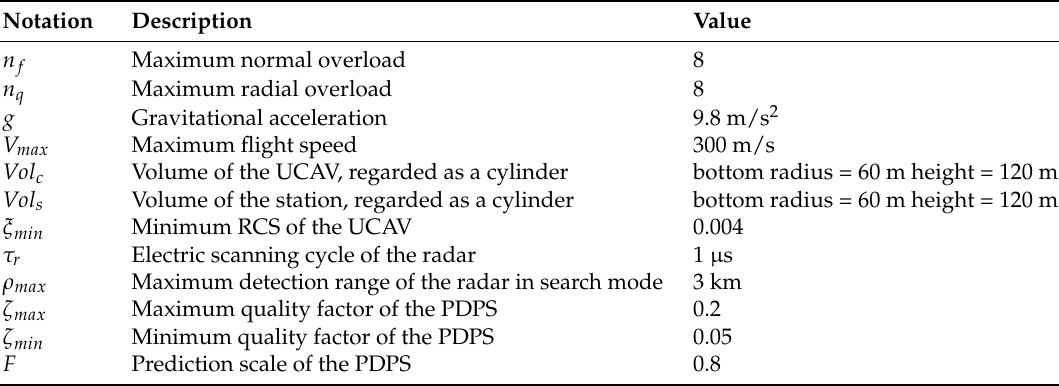
Table 1. Explorer